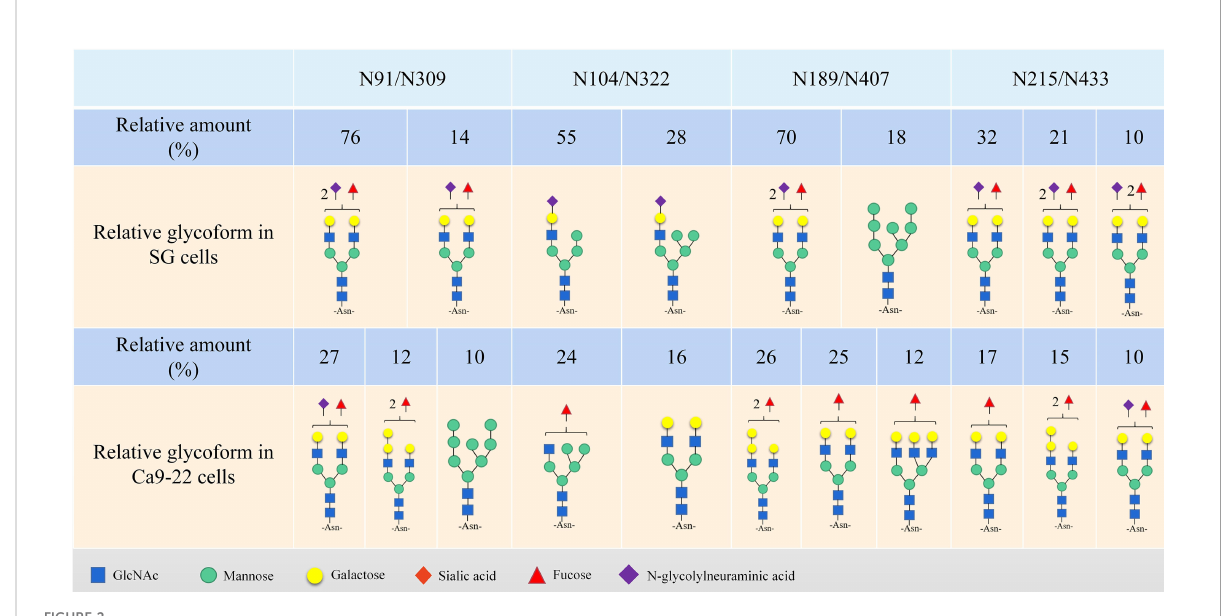
FIGURE 2 Site-speci fi c representative glycans of